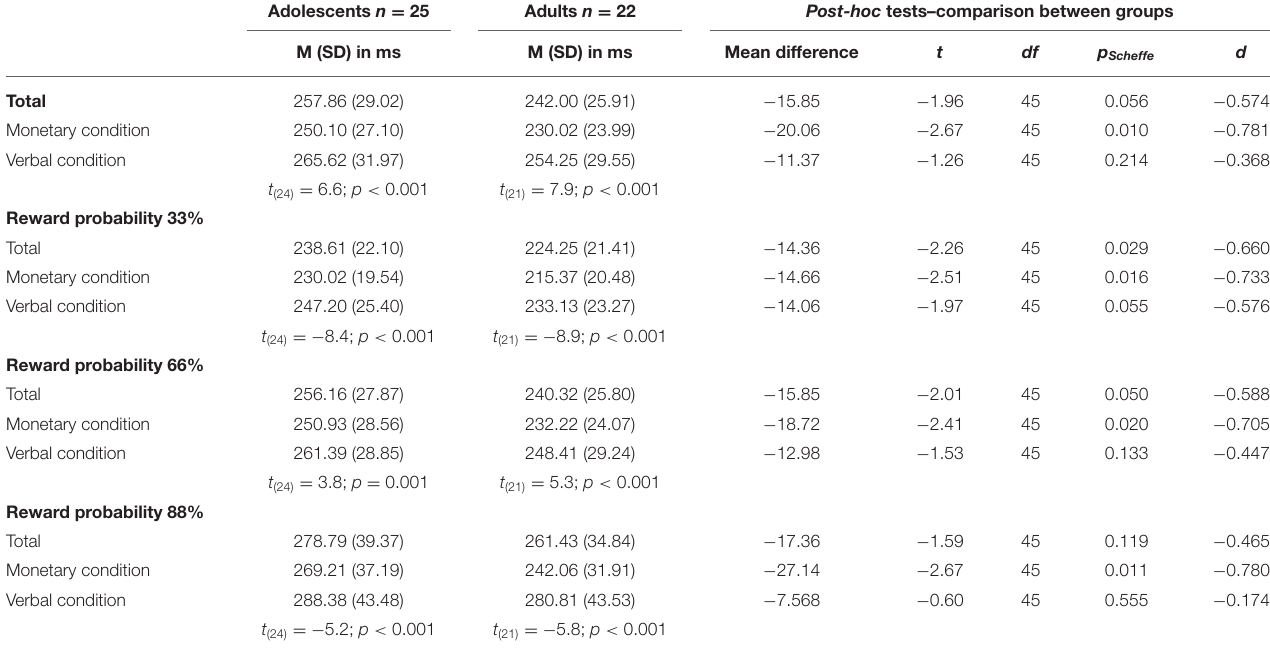
TABLE 2 | Behavioral results: reaction times for both age groups ( n =